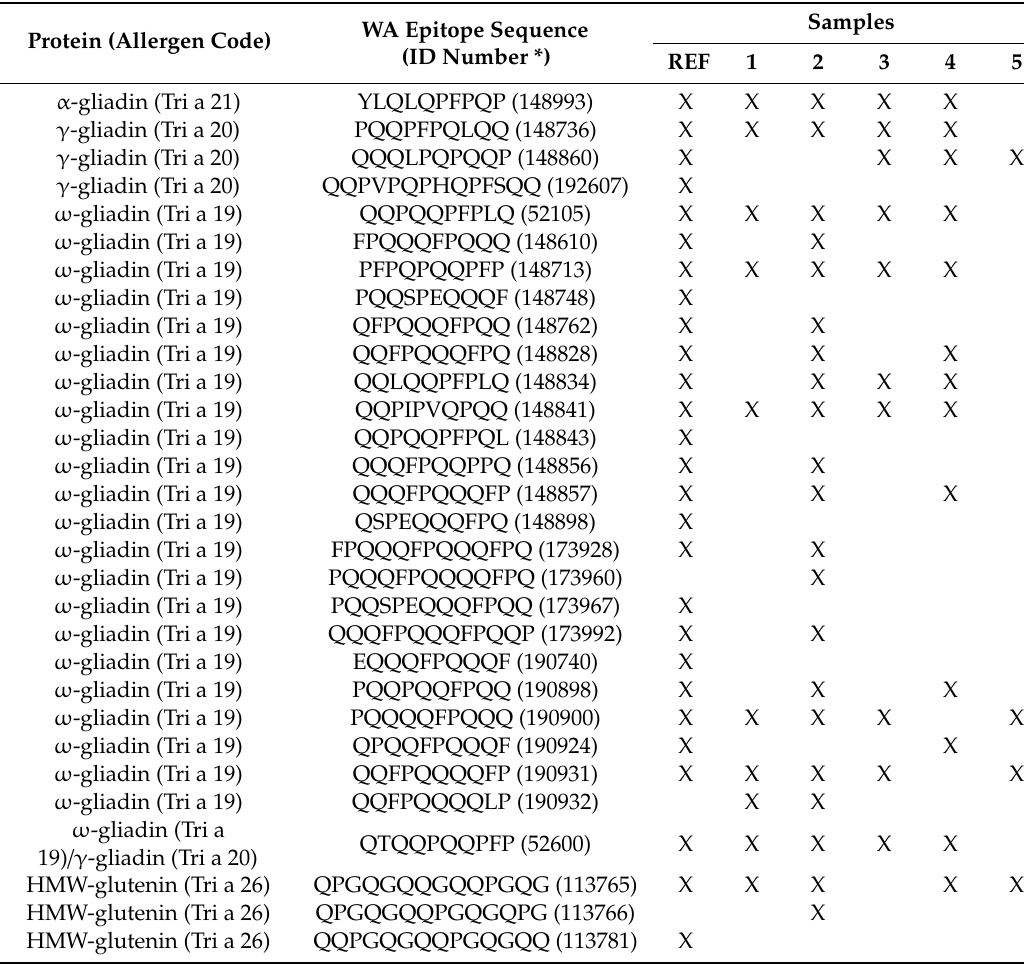
Table 5. Restricted list of gastroduodenal resistant WA epitopes highlighted for their di ff erential expression among the analyzed set of samples (* source https: // www.iedb.org / , accessed in May